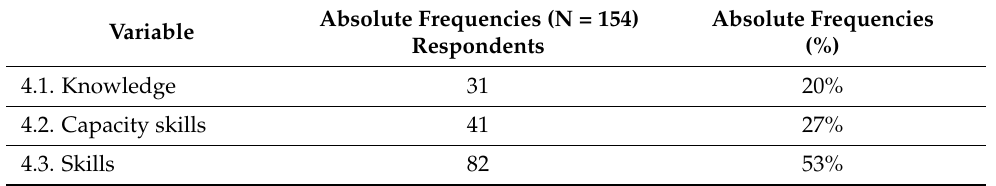
Table 7. Which of the following skills needs to be improved on entrepreneurship in schools? (Question